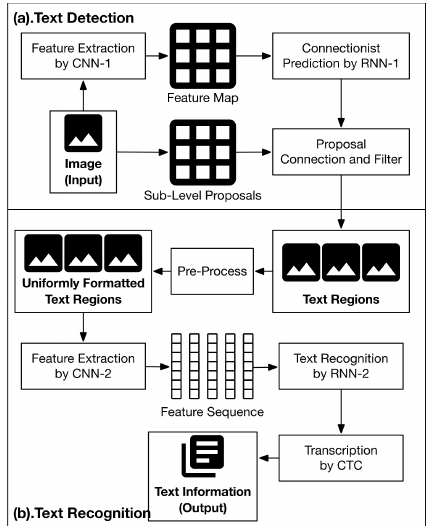
Figure 3. Text information extraction module structure based on deep